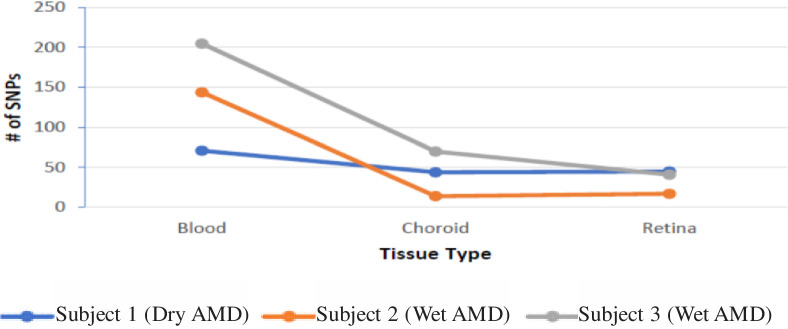
Number of SNPs for subjects and tissue types.